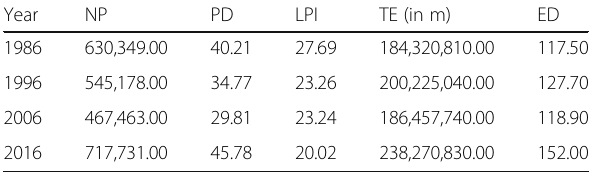
Table 5 Landscape level fragmentation in